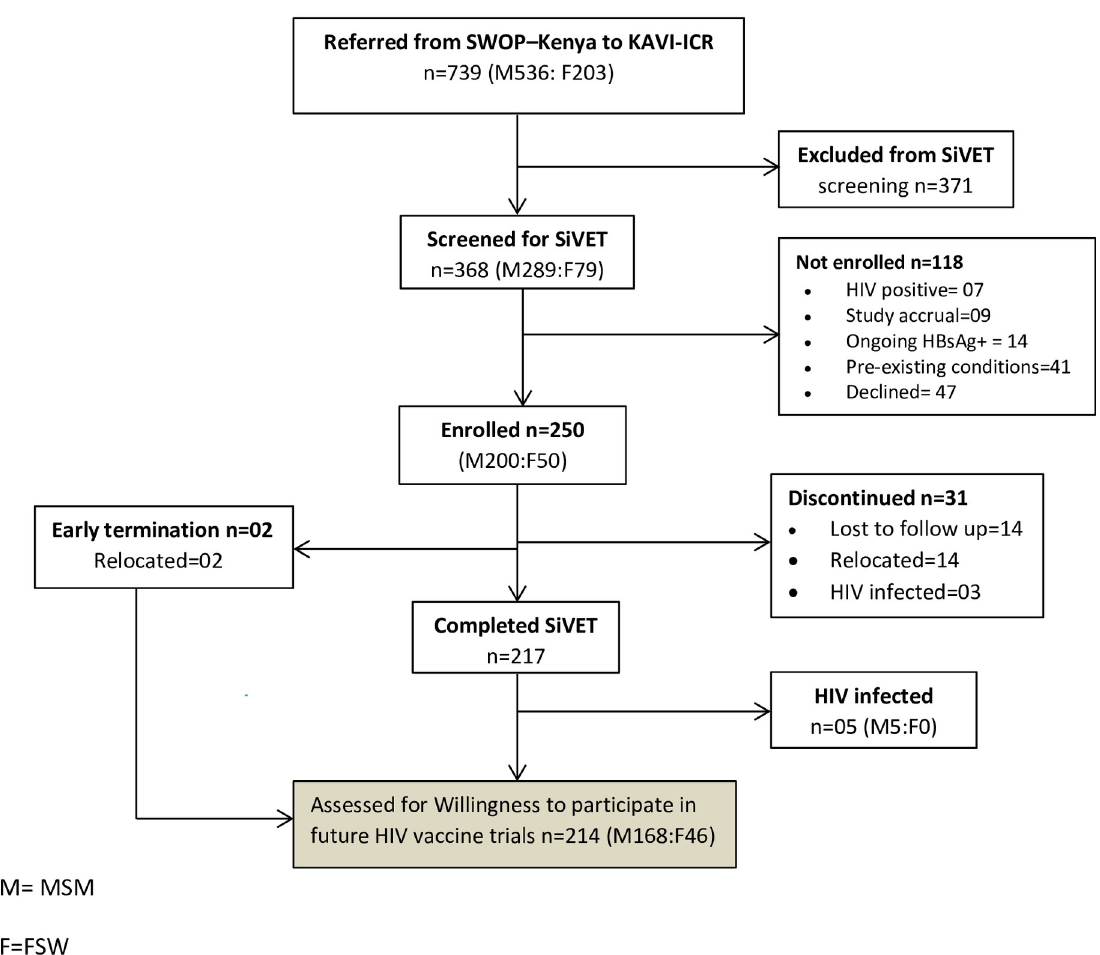
Fig 1. Flow diagram of participant recruitment, screening, enrollment into SiVET study and assessment of willingness to participate in future HIV vaccine trials. M = MSM, F = FSW.